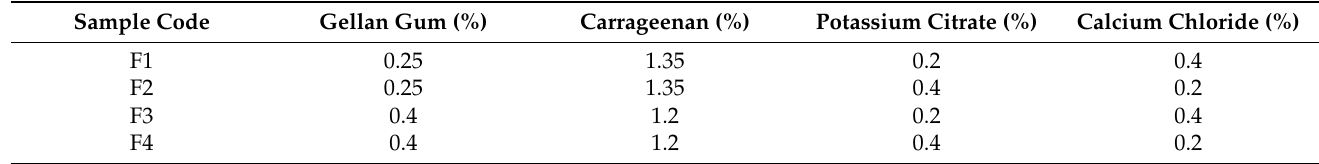
Table 1. Sample code and formulation of hydrocolloid-based